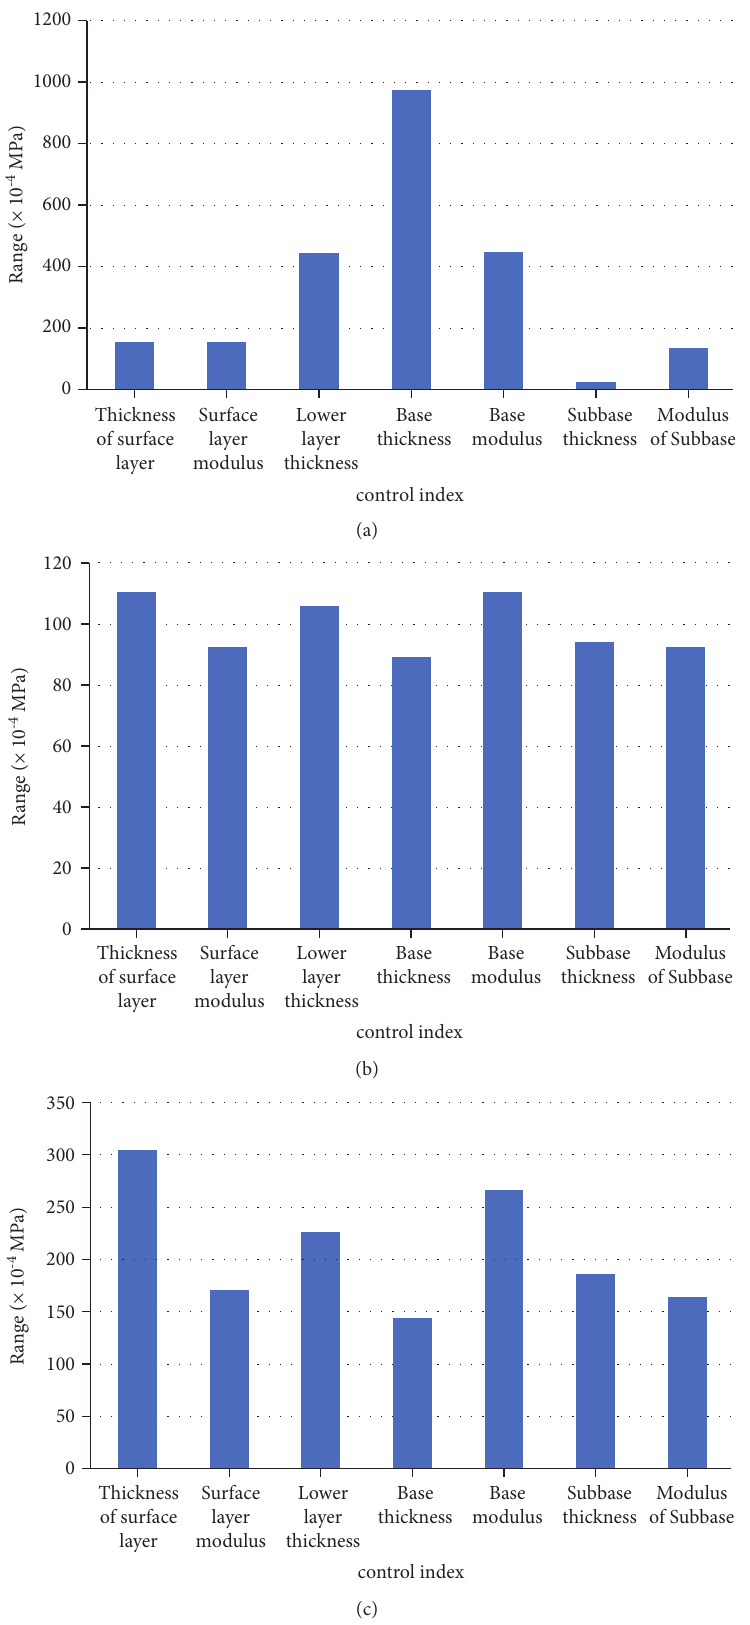
Figure 4: Range diagram of working condition II. (a) Bottom layer tensile stress of inorganic binder stabilizing layer. (b) Permanent deformation of asphalt concrete surface layer. (c) Permanent deformation of the lower layer of asphalt concrete